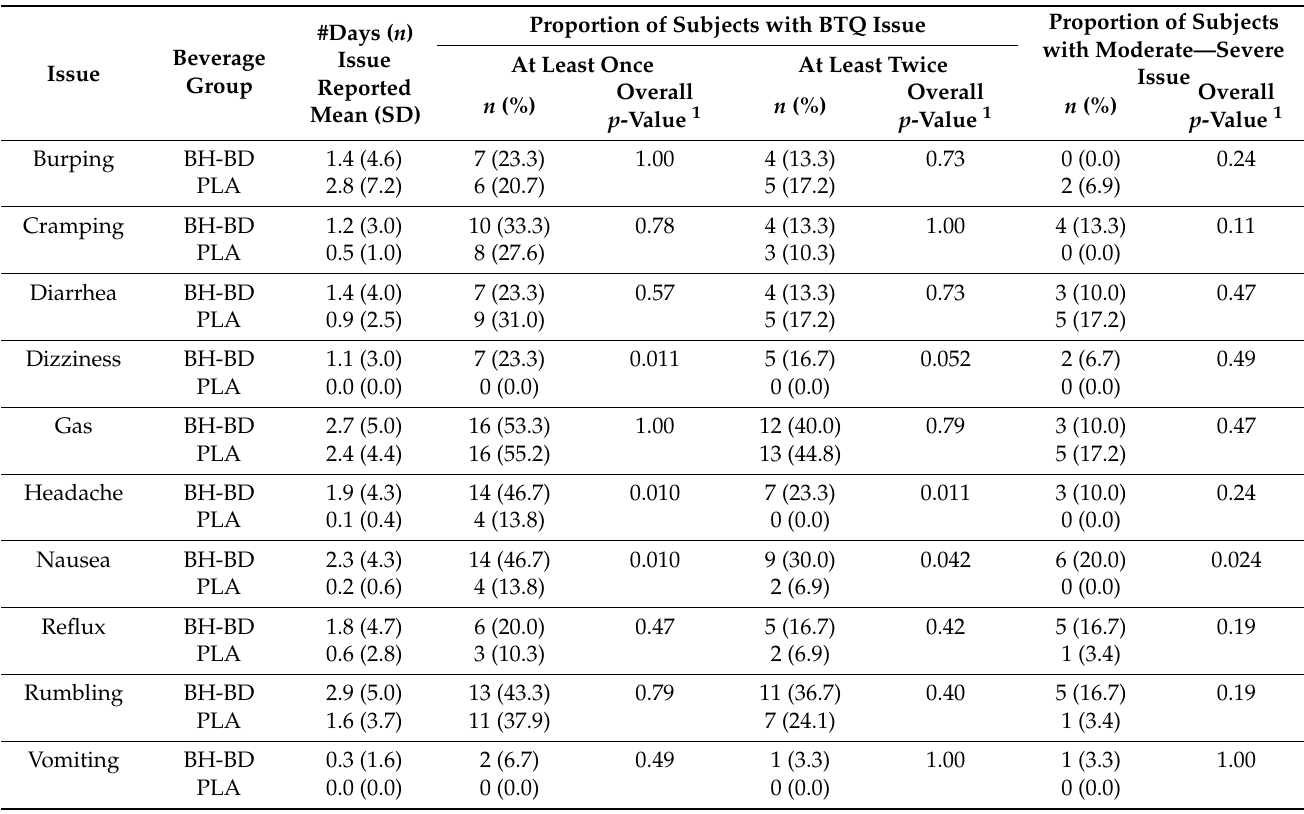
Table 5. Proportion of participants reporting each BTQ symptom on at least one or two or more days and number of participants who reported moderate or severe issues during the 28-day